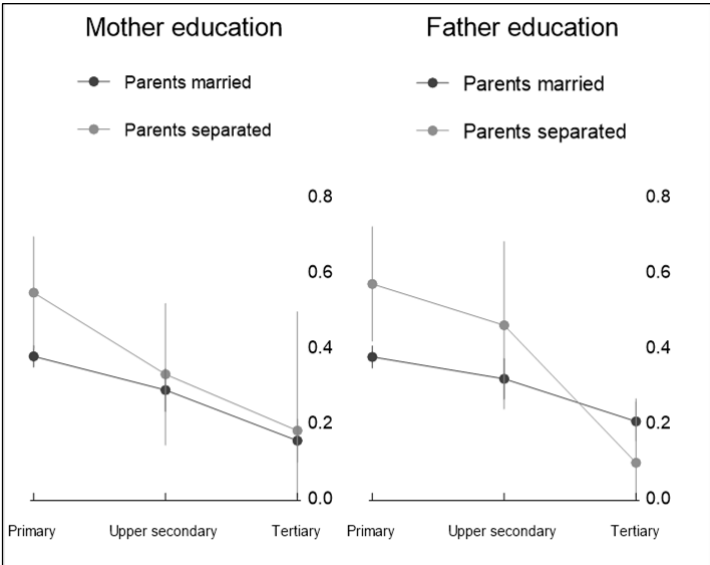
Source : Elaboration of the authors based on ESGE